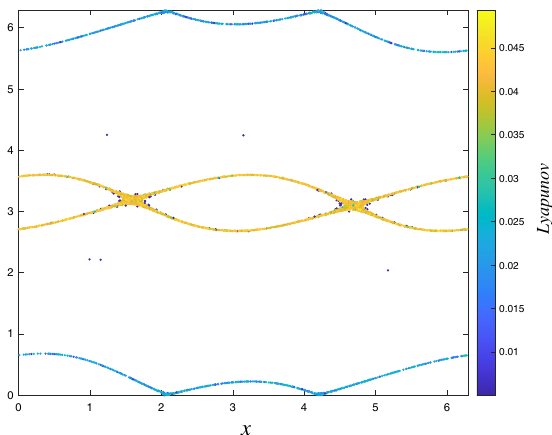
Figure 6. Discrimination of chaotic regions with different chaoticities that contribute two Gaussians to the probability distribution in the ( W = 2 , K = 0.1 )